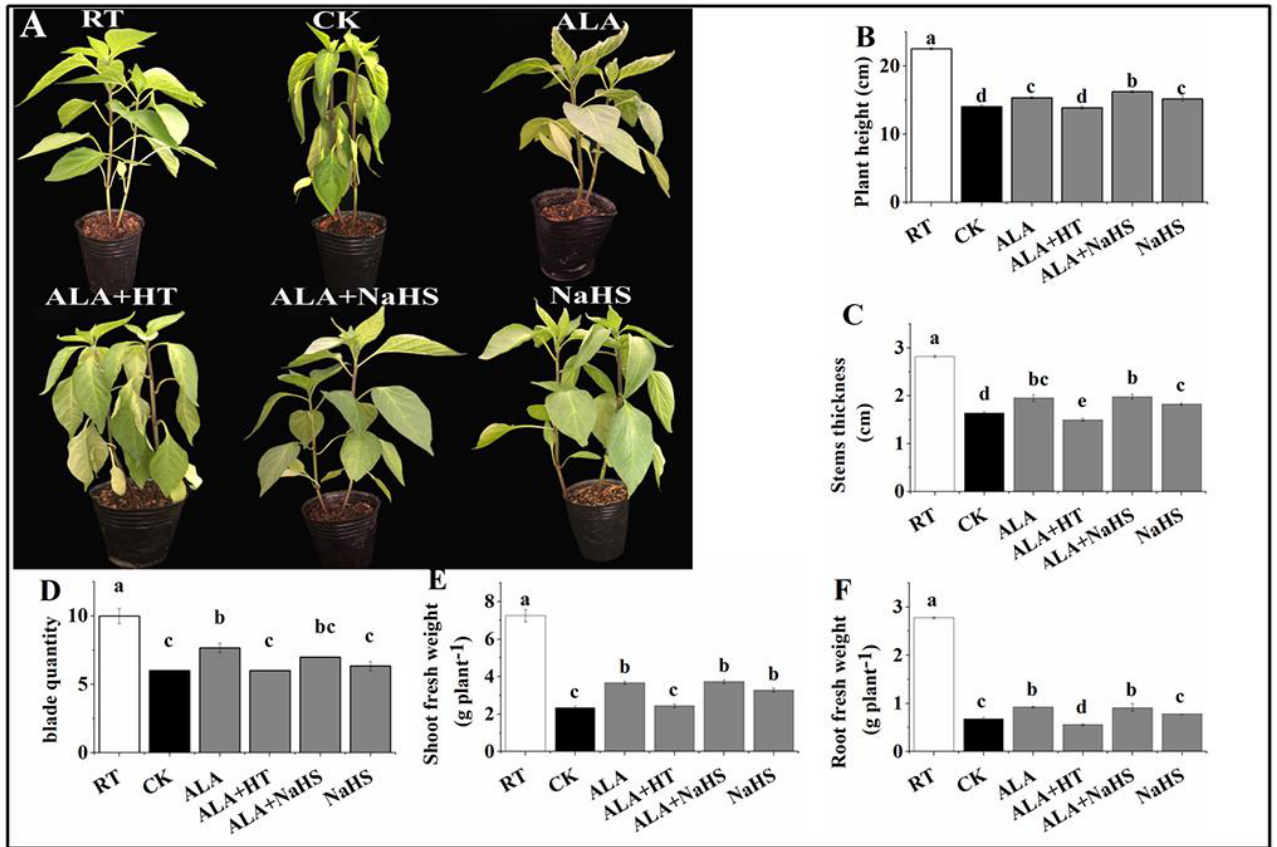
Figure 1. Effects of ALA and/or H 2 S on the phenotype under chilling stress and the growth under chilling stress in pepper seedlings: ( A ) the phenotype under chilling stress for 24 h, ( B ) plant height for 1 week, ( C ) stems thickness for 1 week, ( D ) blade quantity for 1 week, ( E ) shoot fresh weight for 1 week, and ( F ) root fresh weight for 1 week. NaHS: a producer of H 2 S; HT: an H 2 S scavenger. RT: 28 °C/18 °C day/night temperature and 300 μmol∙m −2 ∙s −1 light intensity; CK: 10 °C/5 °C day/night temperature and 100 μmol∙m −2 ∙s −1 light intensity); ALA: 25 mg/L ALA +10 °C/5 °C day/night tem- perature and 100 μmol∙m −2 ∙s −1 light intensity; ALA + H T: 25 mg/L ALA + 150 μmmol/L HT + 10 °C/5 °C day/night temperature and 100 μmol∙m −2 ∙s −1 light intensity); ALA + NaHS: 25 mg/L ALA + 1 mmol/L NaHS +10 °C/5 °C day/night temperature and 100 μmol∙m −2 ∙s −1 light intensity; NaHS: 1 mmol/L NaHS +10 °C/5 °C day/night temperature and 100 μmol∙m −2 ∙s −1 light intensity. The error bars are the standard errors for 6 independent tests. Different letters show significant differences ( p < 0.05) based on Duncan’s test.